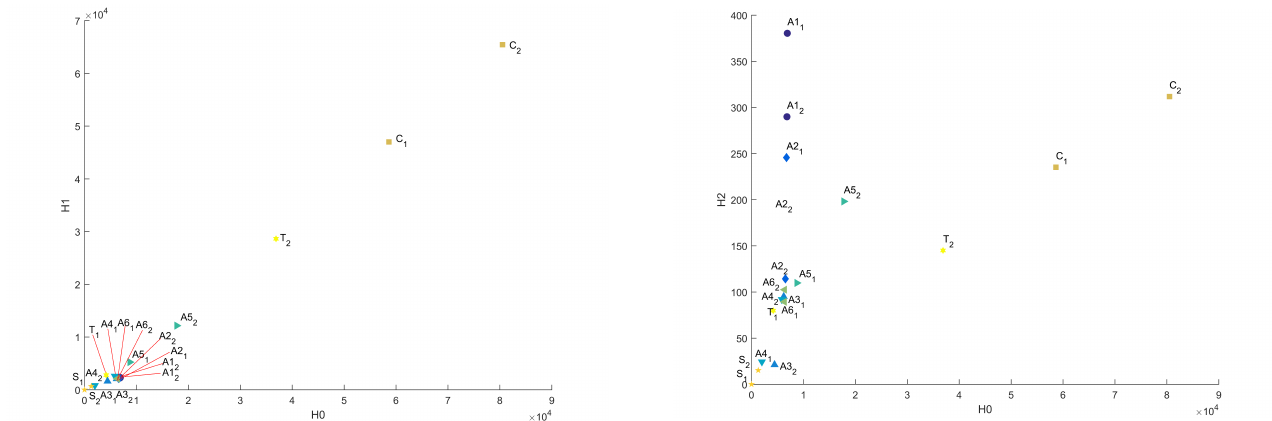
Figure 8. Common distances in Sliced Wasserstein metric in H 0 – H 1 and H 0 – H 2